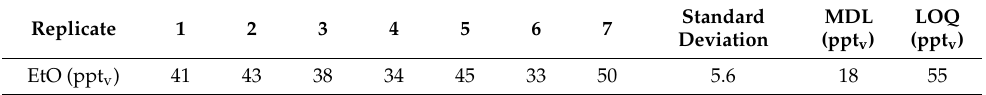
Table 7. Method Detection Limit Study results, done in 50% humid air.